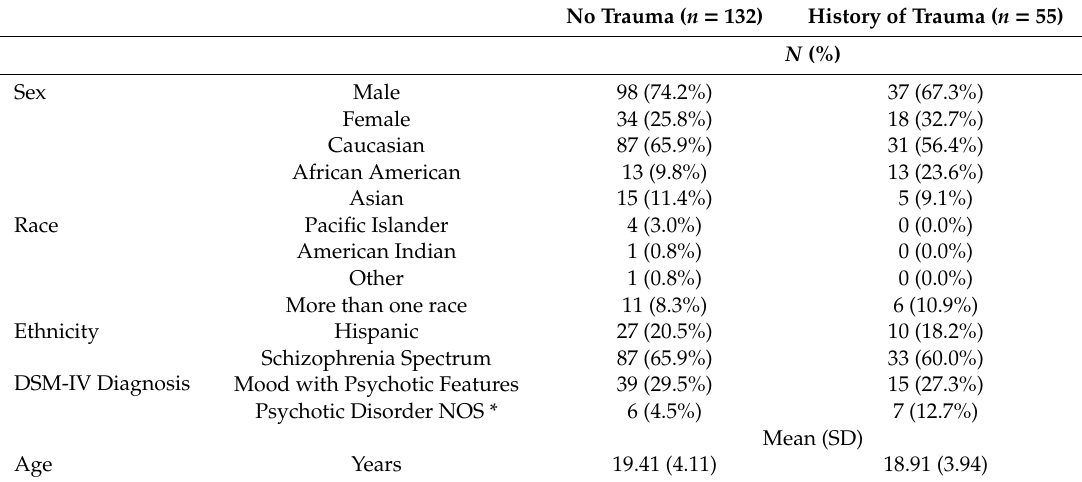
Table 1. Demographics characteristics of the sample ( N = 187).